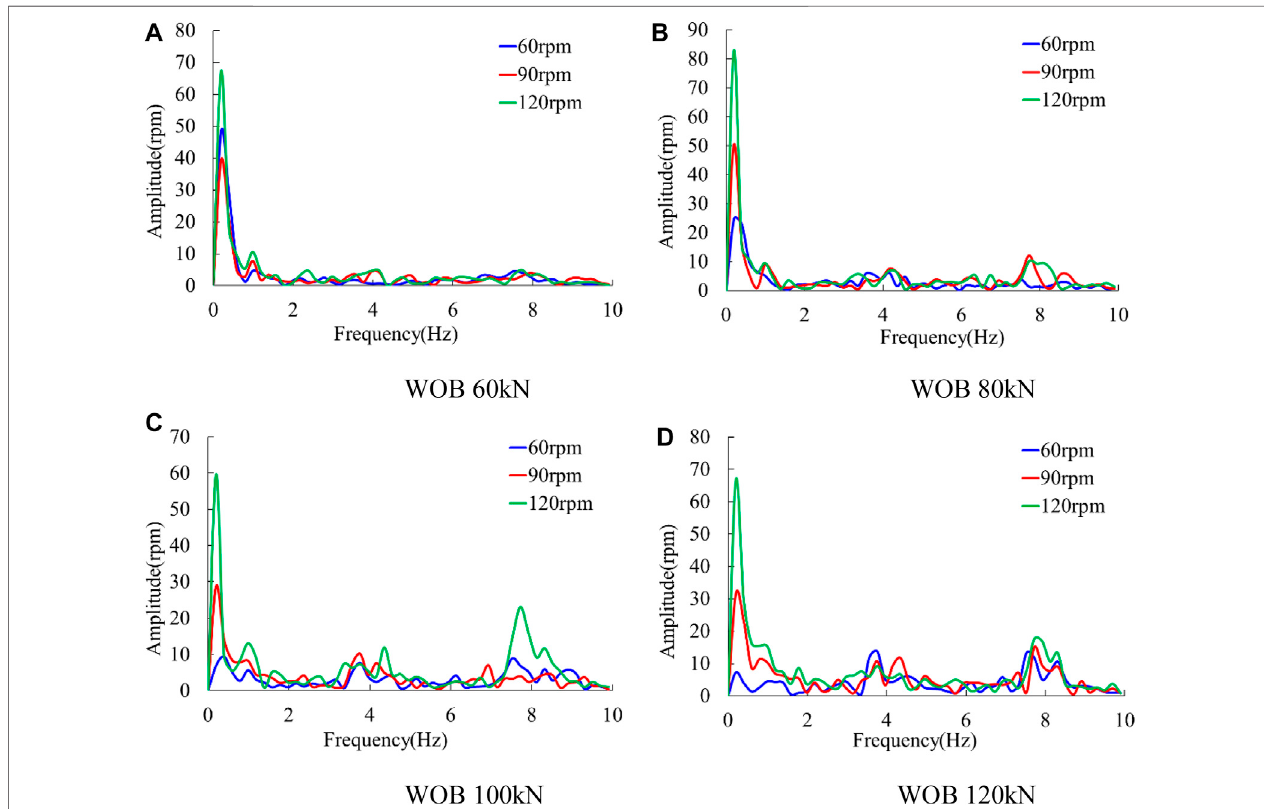
FIGURE 9 | Frequency spectrums of rotation speed at the lower end of drill string.